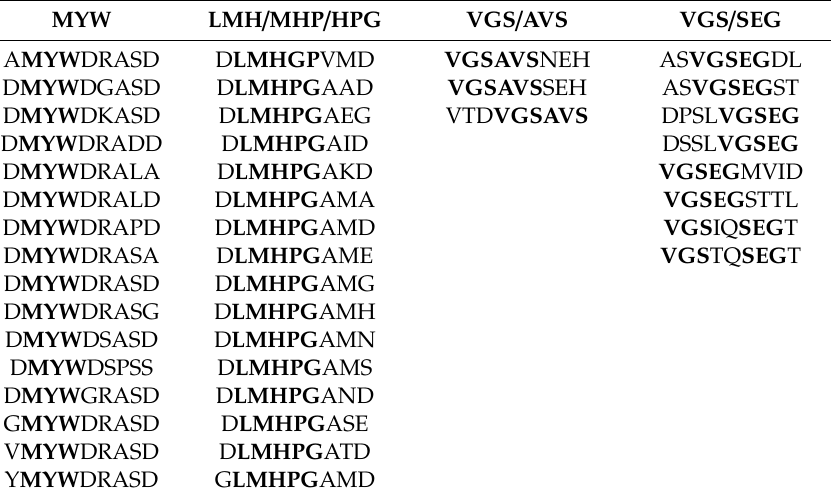
Figure 7. Interaction networks of tumor-selective EBU. Tumor-selective EBUs were plotted as a network graph as nodes that were connected by weighted edges (thicker line between nodes) representing the number of peptides containing both EBUs within the same structure. ( A ) Simple EBU network, noted by the highlighted red path, demonstrating linkage of individual motifs with limited diversity of neighboring EBU interactions. ( B ) Complex EBU network, noted by the two highlighted paths (red and blue), demonstrating linkage of motifs with diverging paths with neighboring EBUs. Table 1. Peptides identified by network analysis of EBUs (indicated in